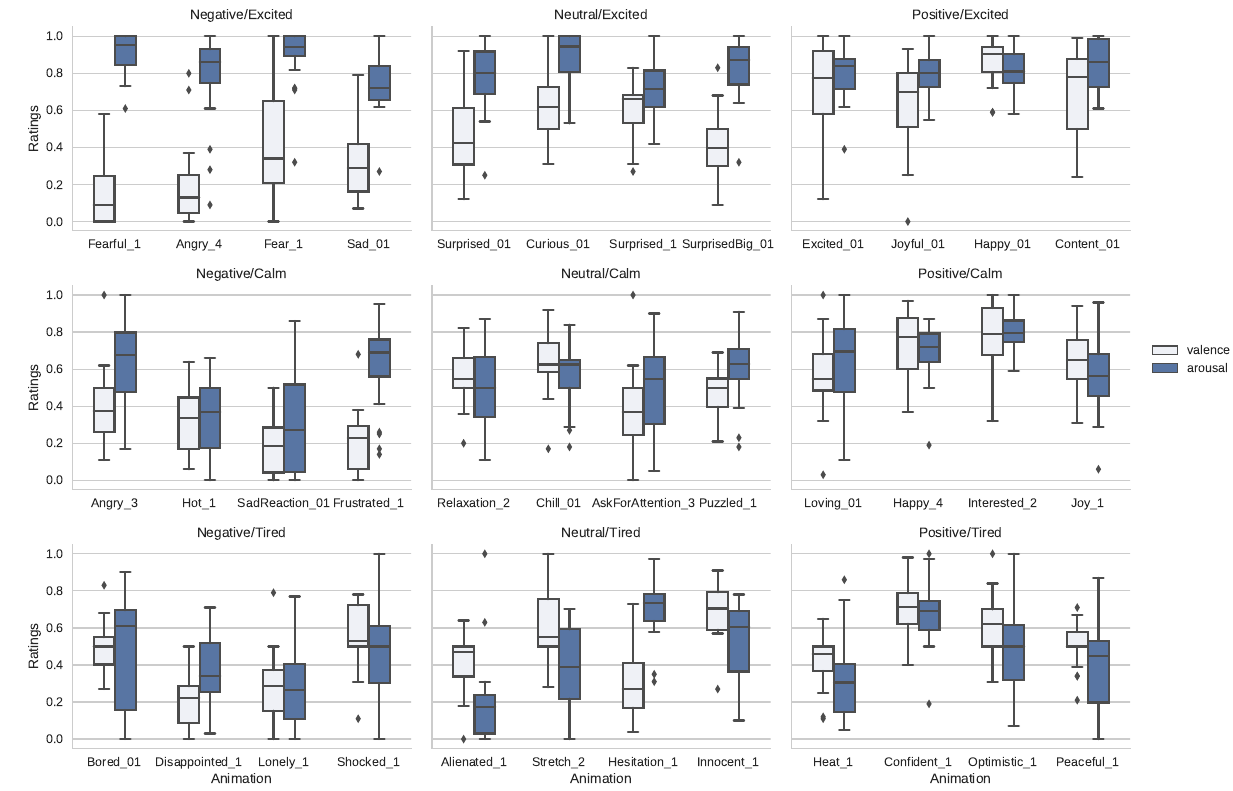
Figure 7: Box plots of the ratings collected from the whole group of participants (N=20) per class of animations (9 classes with 4 anima- tions each). The classes are labeled as combinations of valence and arousal levels. Individual animations are referenced with the original categorical tag assigned by the animators during the creation phase.